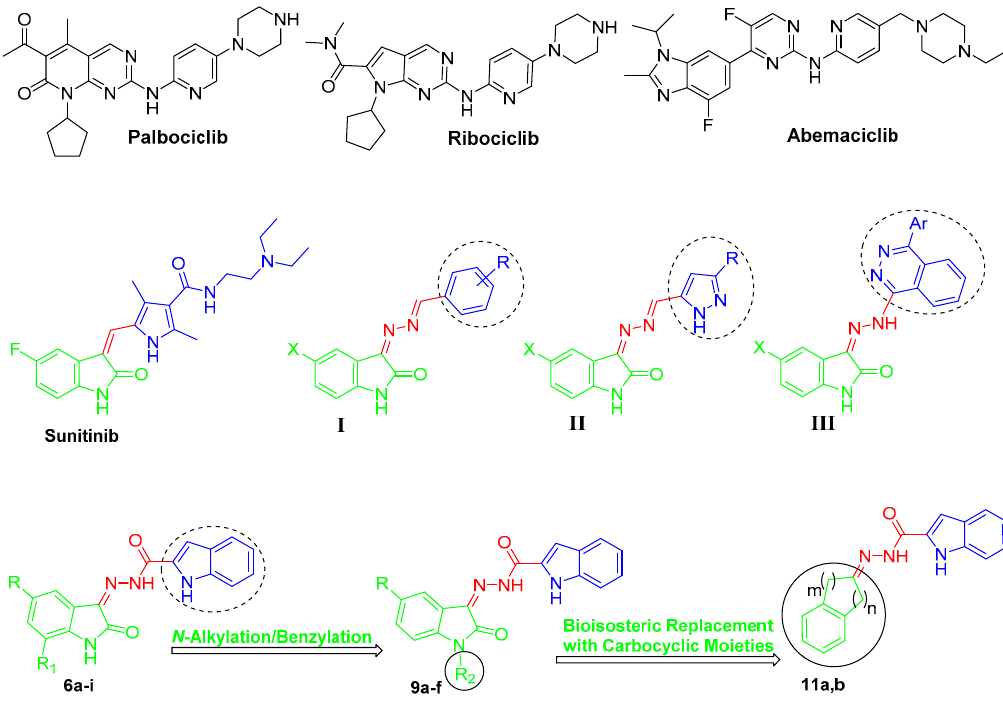
Figure 1. Chemical structures for the approved CDK4 / 6 inhibitors (palbociclib, ribociclib, and abemaciclib), approved oxindole-based anticancer drug (sunitinib), some reported oxindole-based